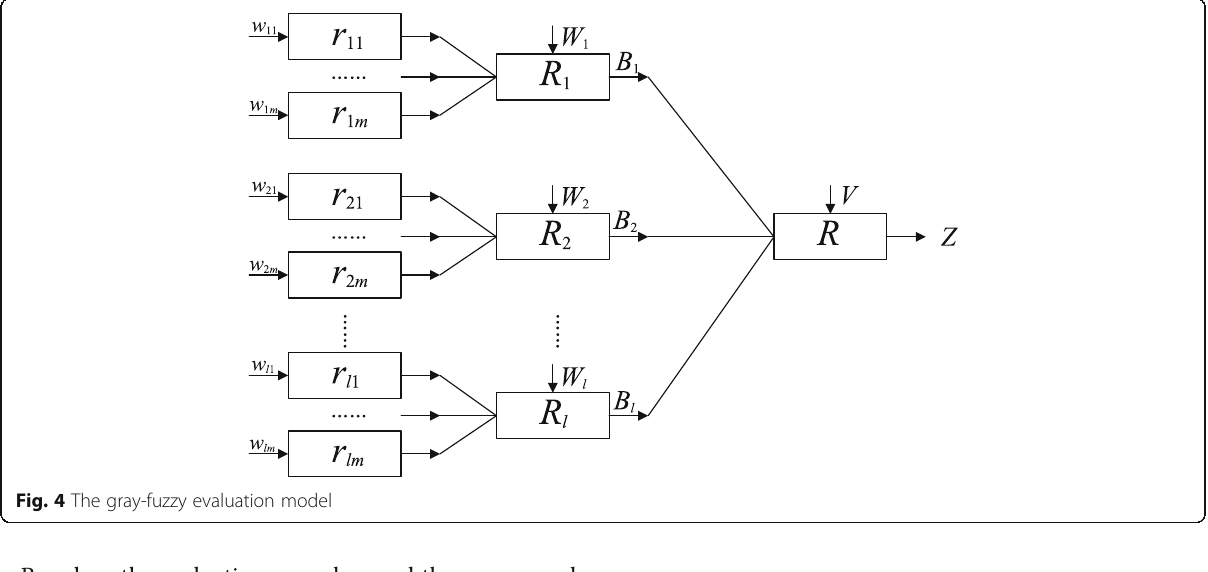
Fig. 4 The gray-fuzzy evaluation model